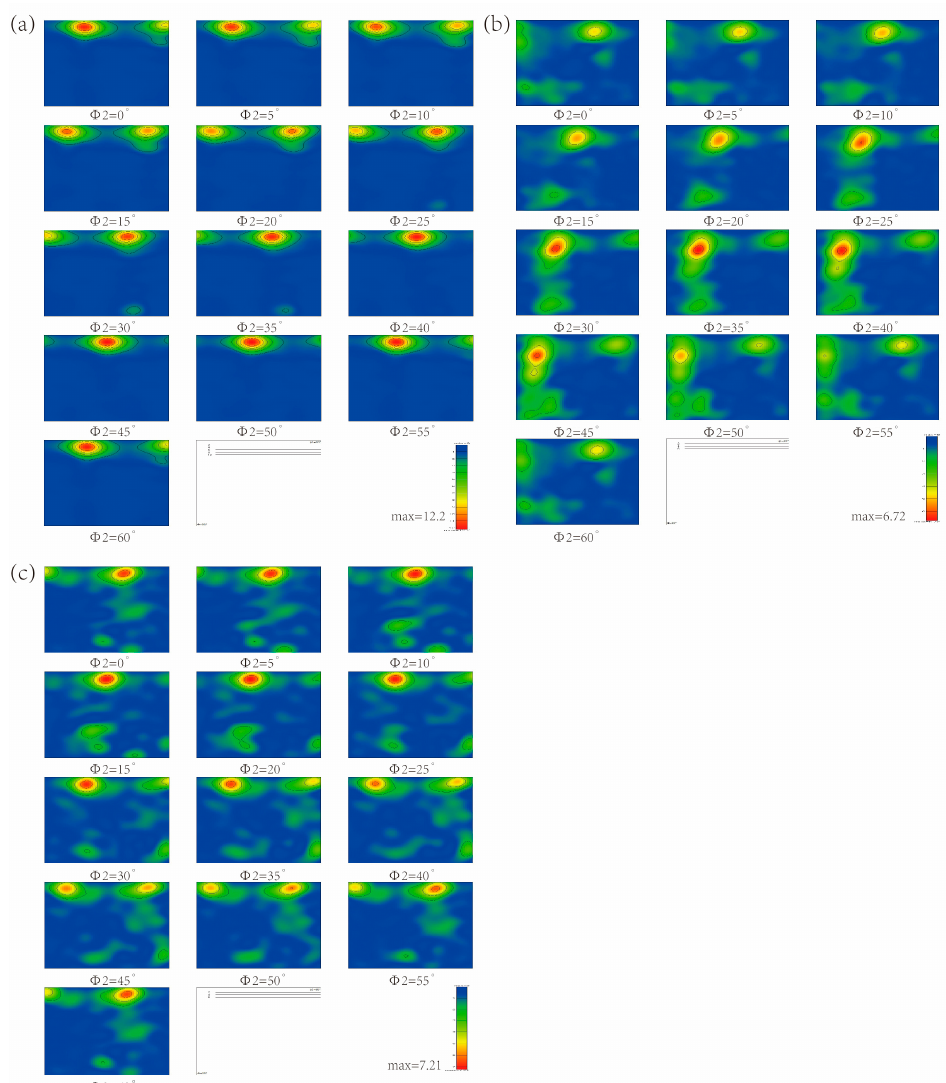
Figure 8. ODF image of TC4 alloy after one cycle of MDIF: ( a ) one pass; ( b ) two passes; ( c ) three passes.